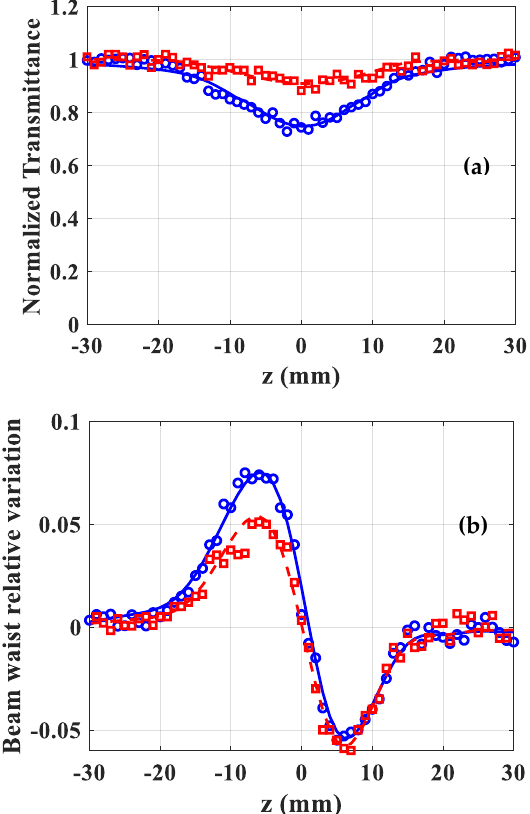
Figure 11. Nonlinear absorption ( a ) and refraction ( b ) of A and B-type suspension of ZnO particles in chloroform at 355 nm (red square: A-type; blue circles: B-type). Solid and dashed (blue and red) lines are fittings.